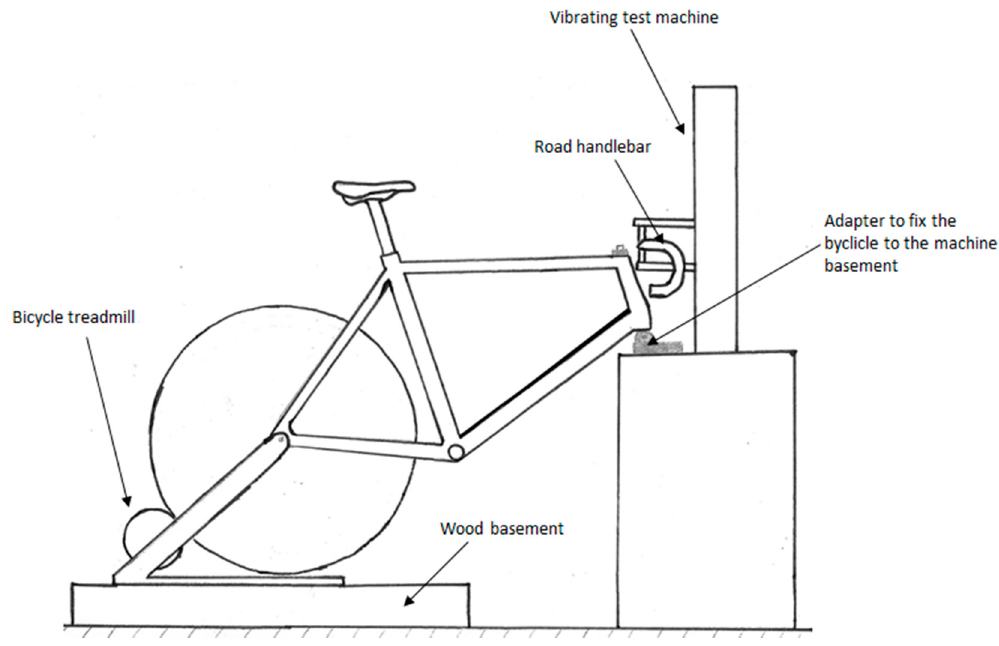
Figure 2. Laboratory test